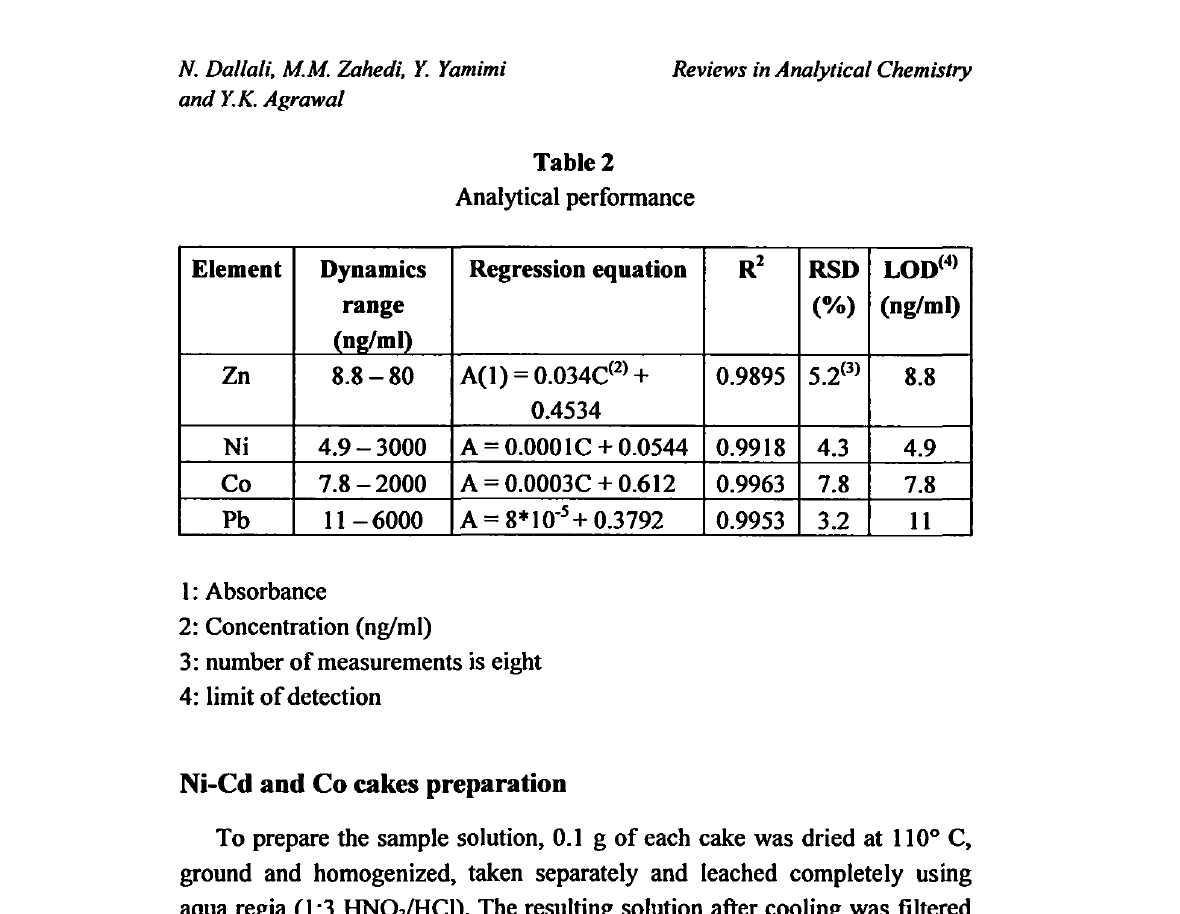
Effect of diverse ions on recovery of